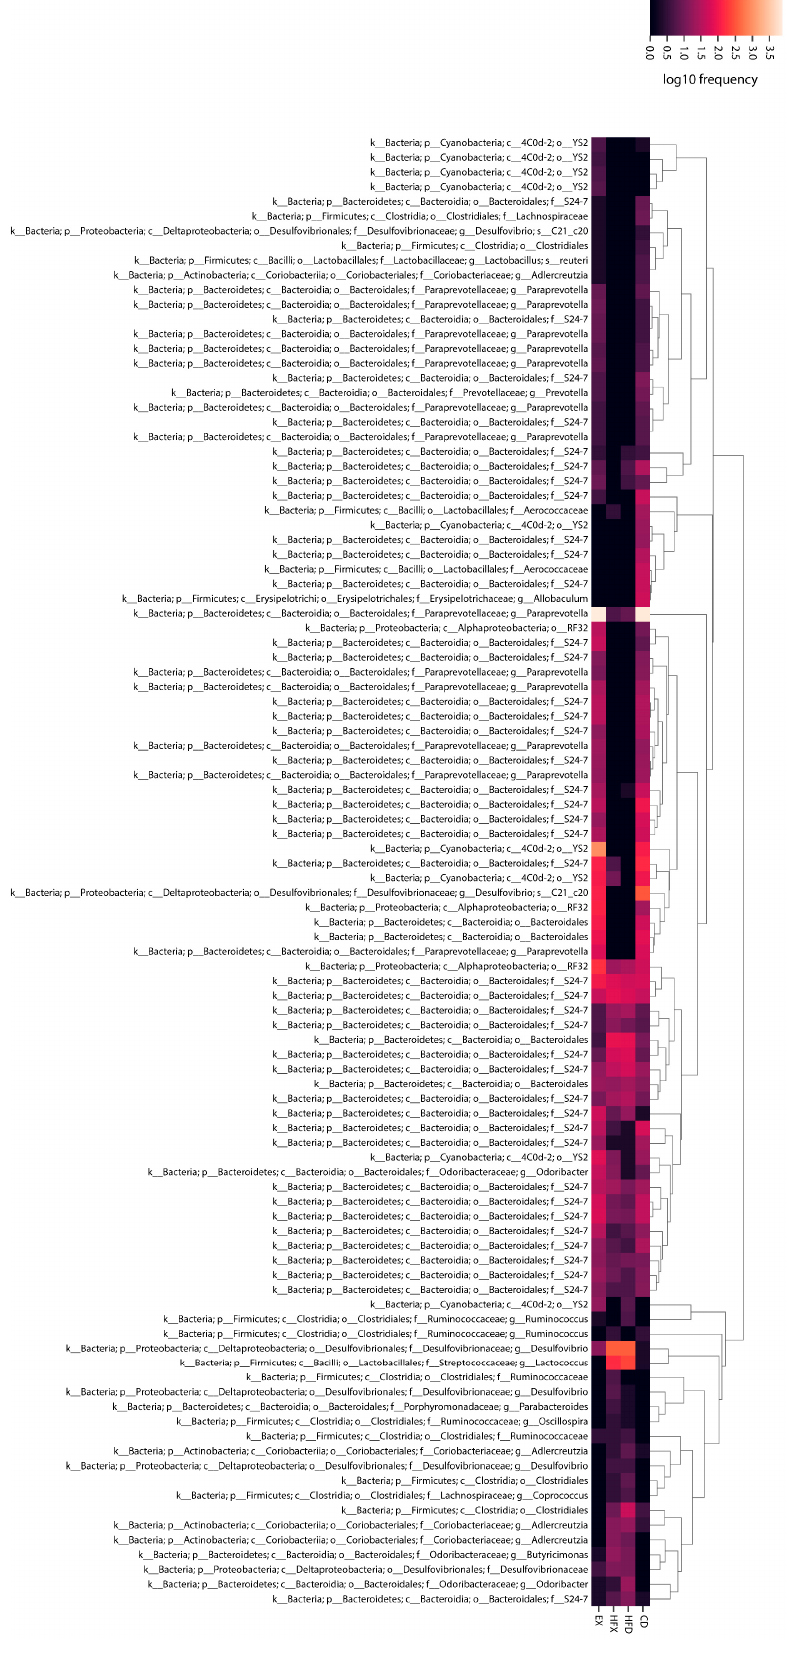
Figure 6. Heatmap showing the most important taxa among experimental groups.